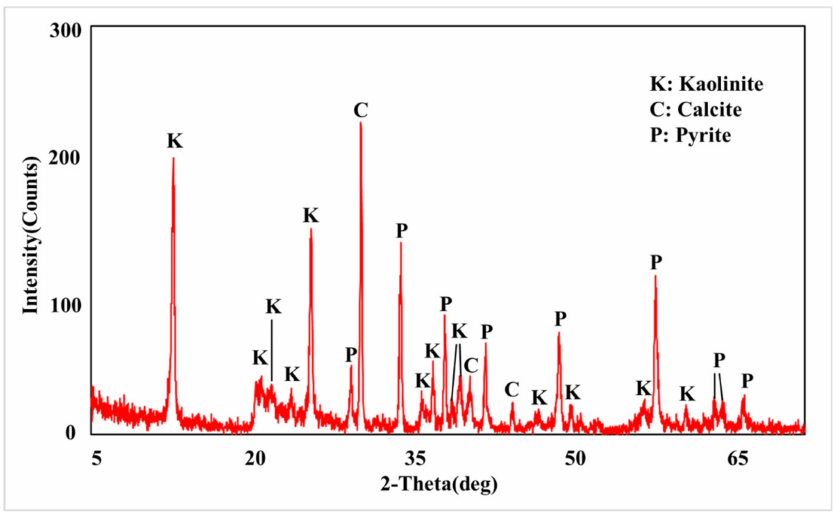
Figure 3. The XRD pattern of LTA residues of sample WJW-6 from Wujiawan mine, Datong